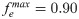
Stability of individual communication strategies.(A) Distribution of the fraction of emails sent by users to pre-existing contacts fi (see text). The line shows the kernel density estimation of the three yearly datasets pooled together. Most users exchange most of their emails with preexisting contacts. with the maximum at femax=0.90. (B) Distribution of the change of fi, Δfi(Δt) = fi(t + Δt) − fi(t) for Δt = 1, 2 years (dots and squares, respectively). The lines show the Laplace best fits based on BIC for the two distributions (P(Δfi)∼exp(−|Δfi − μ|/σ); Δt = 1 σ = 0.18 μ = 0.046; and Δt = 2 σ = 0.19 μ = 0.062). Most of the users keep the number of emails sent to preexisting contacts constant in time, and the distributions are quite stable in time despite a slight shift towards larger changes for larger Δt. (C) Comparison between yearly absolute individual change in the fraction of emails sent to preexisting contacts |Δfi(Δt)|self and the typical differences between users |Δfij|ref = |fi(t) − fj(t)|, ∀j ≠ i. The boxplot shows unambiguously that individual users have a stable communication strategy over time.